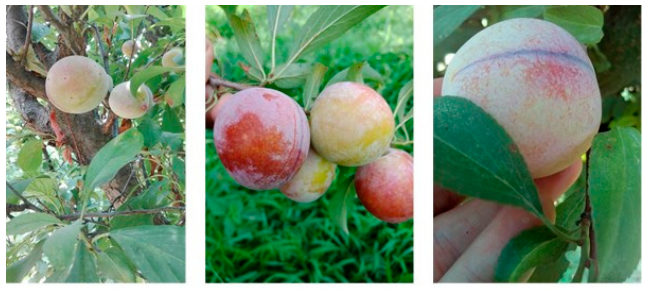
Figure 1. Scale variation in captured images.